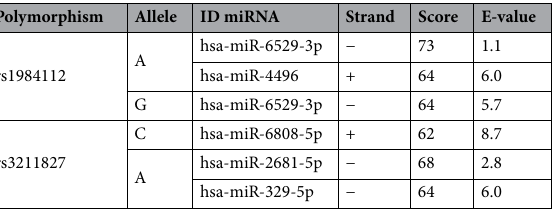
Table 5. Analysis of the significant polymorphisms for similarity with miRBase of mature miRNAs 51 specific to human by using BLASTN search algorithm.